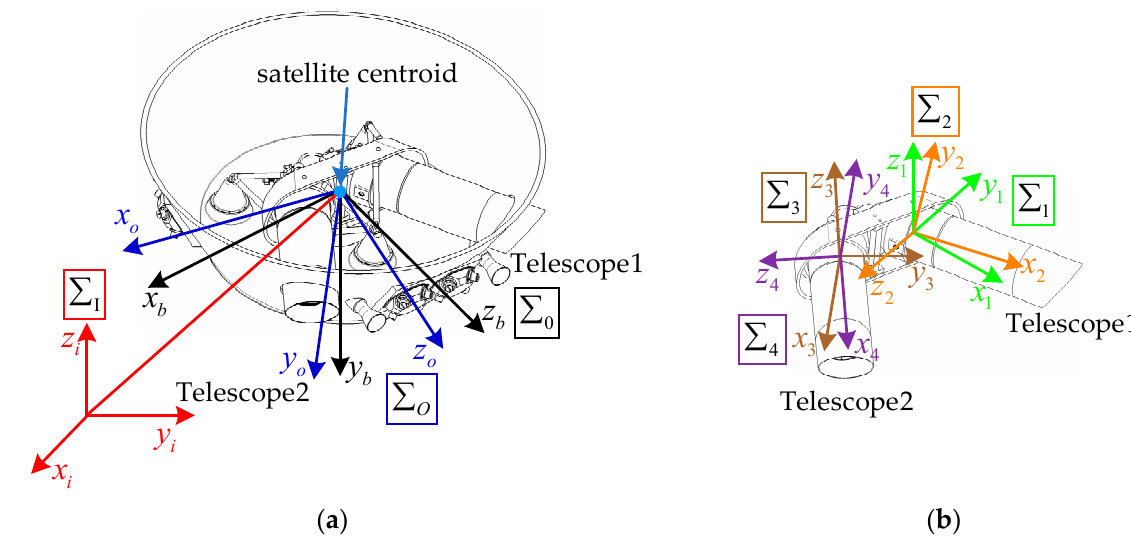
Figure 7. Reference coordinate systems. ( a ) Satellite coordinate systems; ( b ) telescope coordinate systems.